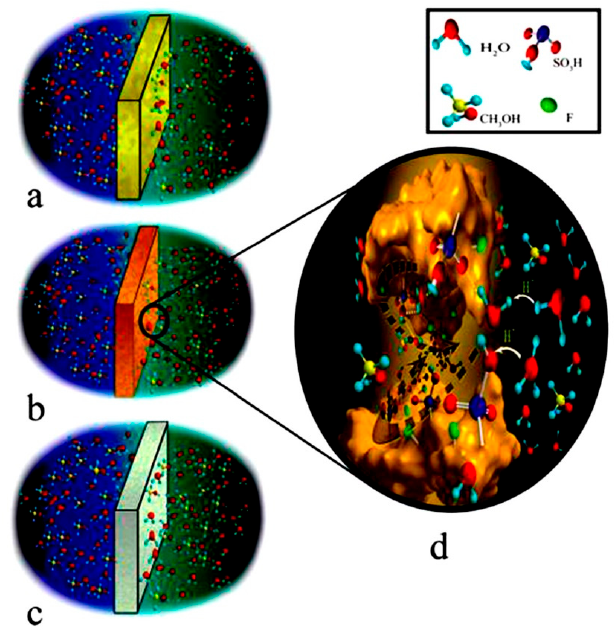
Figure 7. Schematic presentation of water and methanol crossover from ( a ) MS, ( b ) MSSPx, and ( c ) MSPx membranes, and ( d ) proton transferring through the membrane. Reproduced with permission from [73]. Copyright Royal Society of Chemistry,